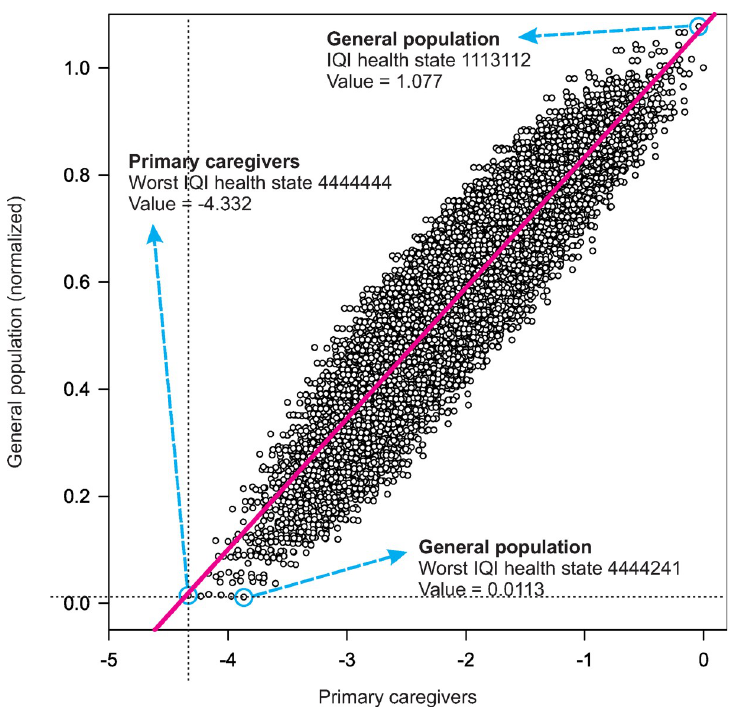
Fig 3. Estimated health-state values obtained for the primary caregivers with discrete choice tasks (pairs of IQI states) and for the general population with a ranking task (two IQI states + death).